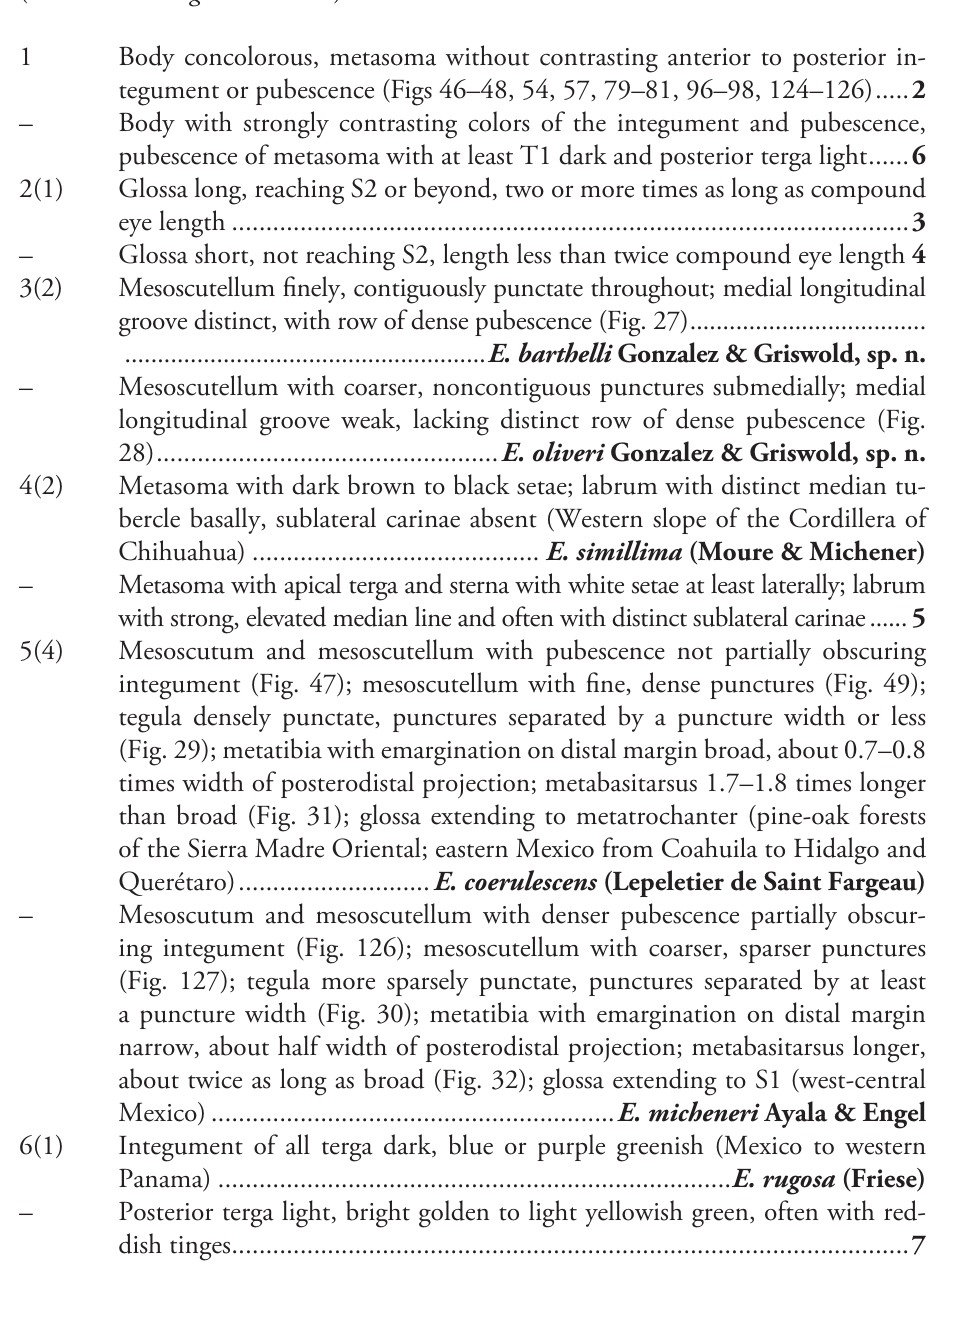
Body concolorous, metasoma without contrasting anterior to posterior in- tegument or pubescence (Figs 46–48, 54, 57, 79–81, 96–98, 124–126) ..... 2